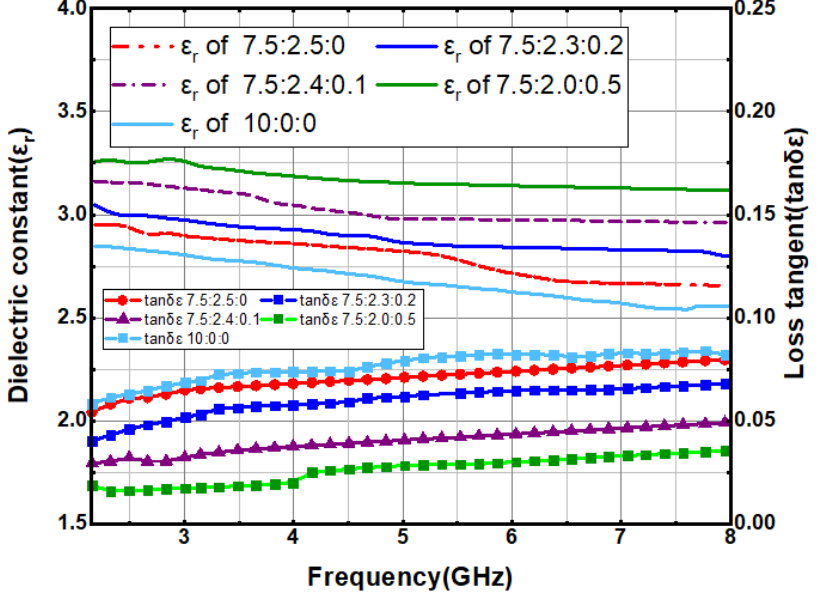
Figure 2. Test results for the dielectric constant and loss tangent of PDMS-Al 2 O 3 -PTFE materials with different doping ratios.